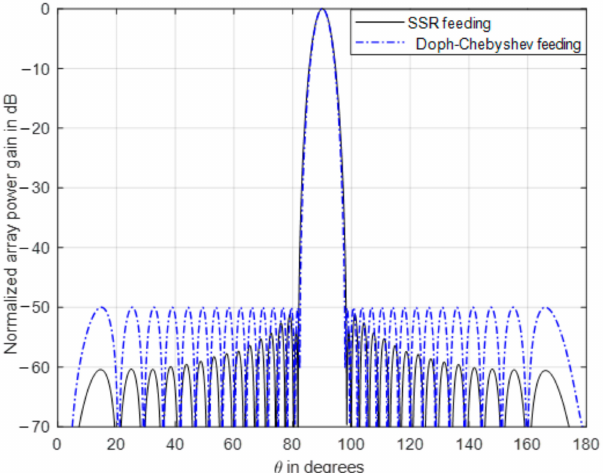
Figure 10. Normalized power pattern for 32-element linear array using SSR algorithm feeding and Dolph-Chebyshev